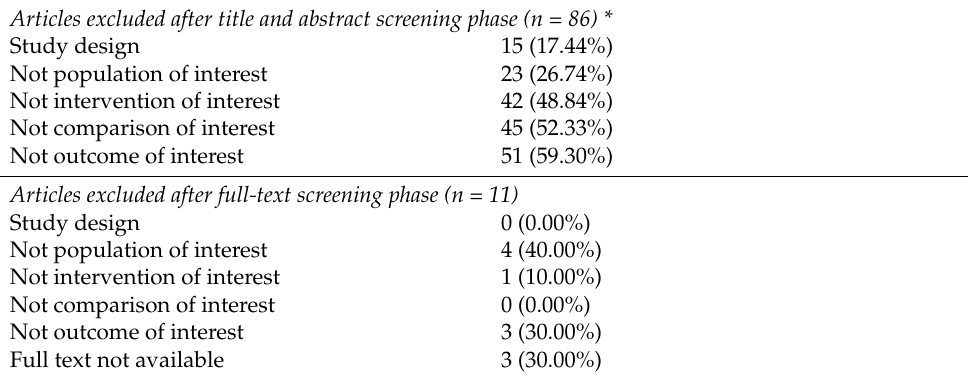
Table 2. Reasons for article exclusion by the present systematic review.